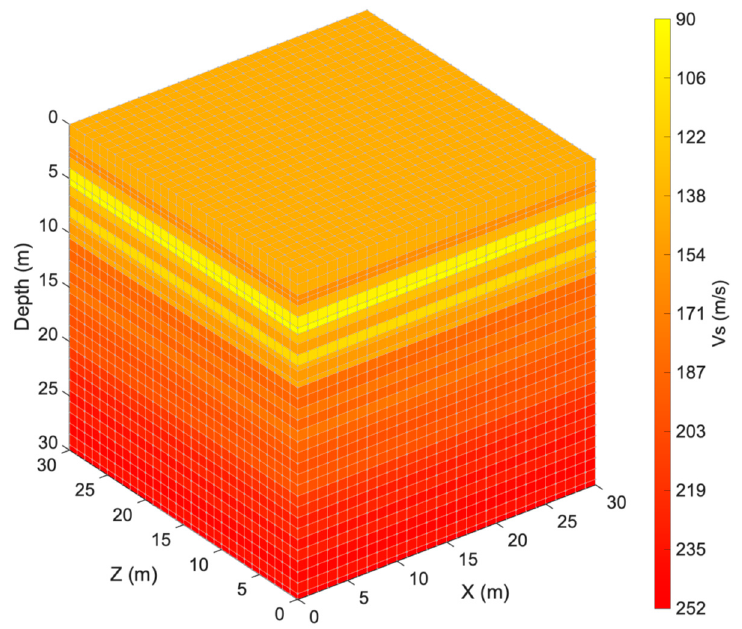
Figure 9. Developed soil-block model for the BOWW soil profile, with size 30 × 30 × 30 m 3 .